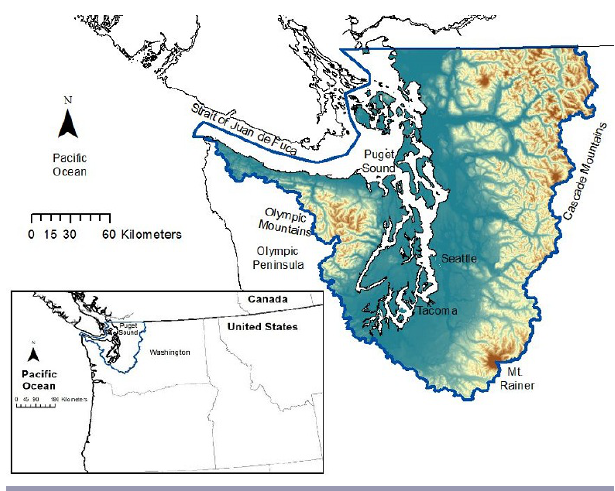
Fig. 2 . Puget Sound case study